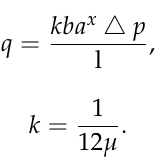
Figure 3. The fluid flow rate of contact.